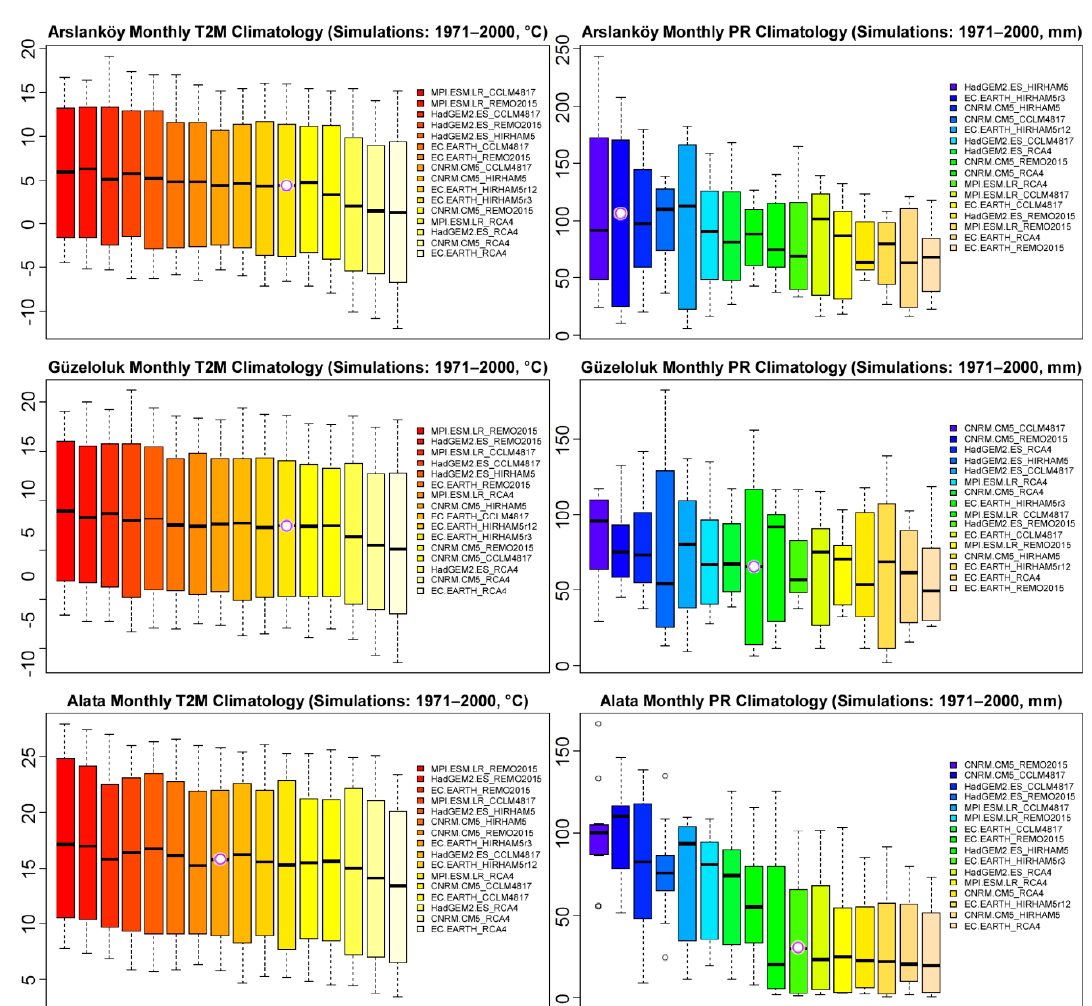
Figure 5. The seasonality of each temperature and precipitation simulation for the Arslanköy, Güzeloluk and Alata climate stations used in this study; the white circle highlights the DMI-HIRHAM5 simulation considering the 16 different simulations.